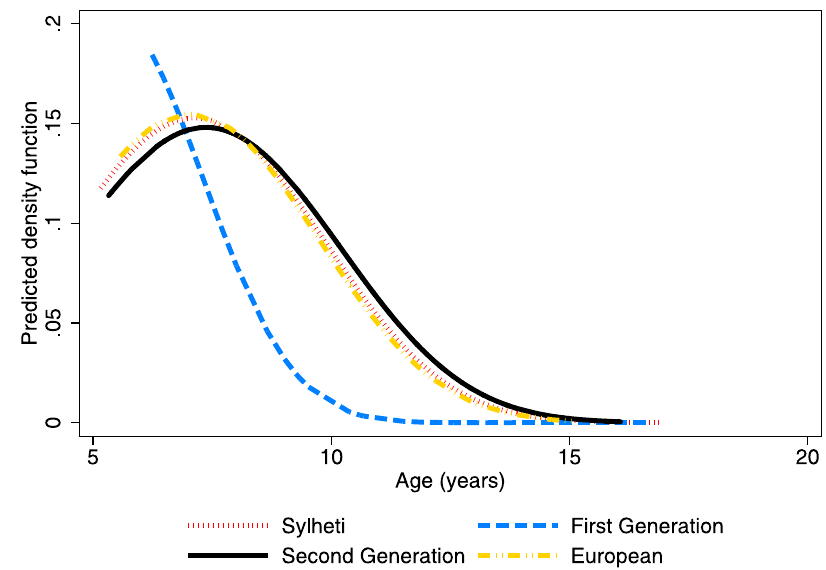
Figure 3. Comparison of the distribution density of the age at onset of adrenarche among Sylheti, first-generation, second- generation, and European girls determined by Weibull regression models for parametric survival analysis. The curves plot the predicted density of adrenarche on the Y axis and by age on the X axis, with the peak of each curve corresponding to the median age at adrenarche. The median age at adrenarche for each migration group was: Sylheti=7.2, first-generation=5.3, second-generation=7.4, Europeans=7.1; p- trend=0.7. First-generation girls reached adrenarche significantly earlier than all other groups (p , 0.01).